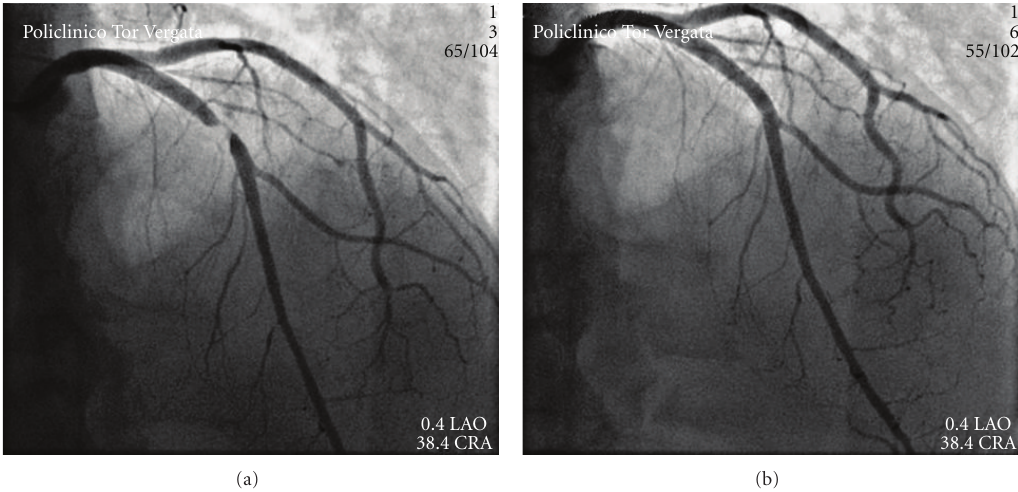
Figure 4: (a) Baseline coronary angiogram (LAO 40 ◦ , CRA 38 ◦ ) and (b) coronary angiogram after successful percutaneous intervention and direct stenting of the LAD (LAO 40 ◦ , CRA 38 ◦ ).